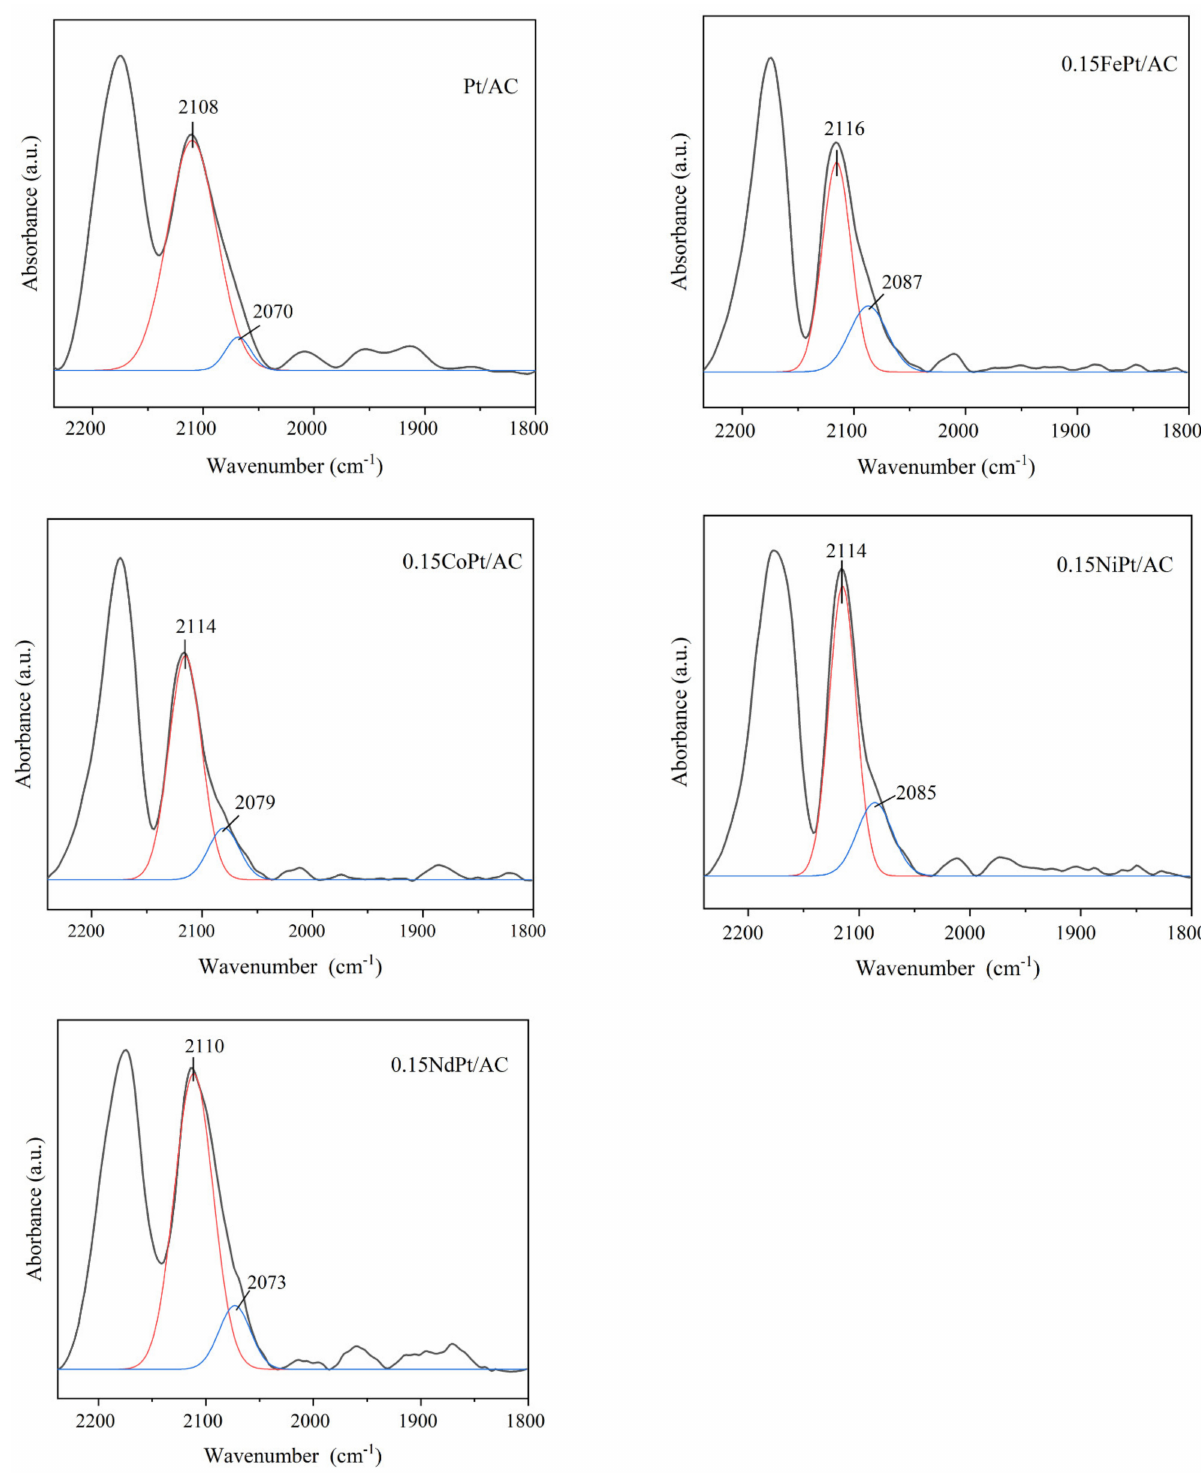
Figure 5. CO-IR result of the Pt-based catalysts. The amounts of CO chemisorption on the Pt/AC and 0.15MPt/AC catalyst are demon- strated in Table 1. The number of surface Pt-active atoms on all the Pt catalysts derived from the CO uptake are ranging between 0.82–5.69 × 10 18 molecules of CO in the order: 0.15FePt/AC > 0.15CoPt/AC > 0.15NdPt/AC > Pt/AC > 0.15NiPt/AC. The relatively